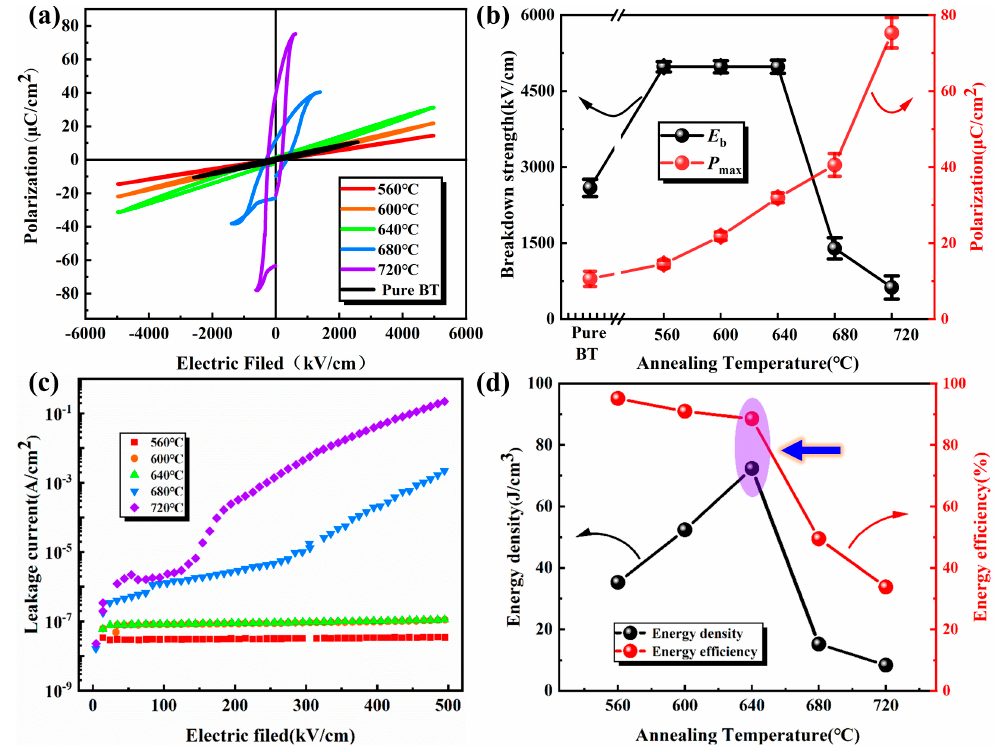
Figure 7. BT-8%Mn films at different annealing temperatures: ( a ) P-E loop; ( b ) P max and breakdown strength; ( c ) leakage current; ( d ) energy storage density and energy storage efficiency.